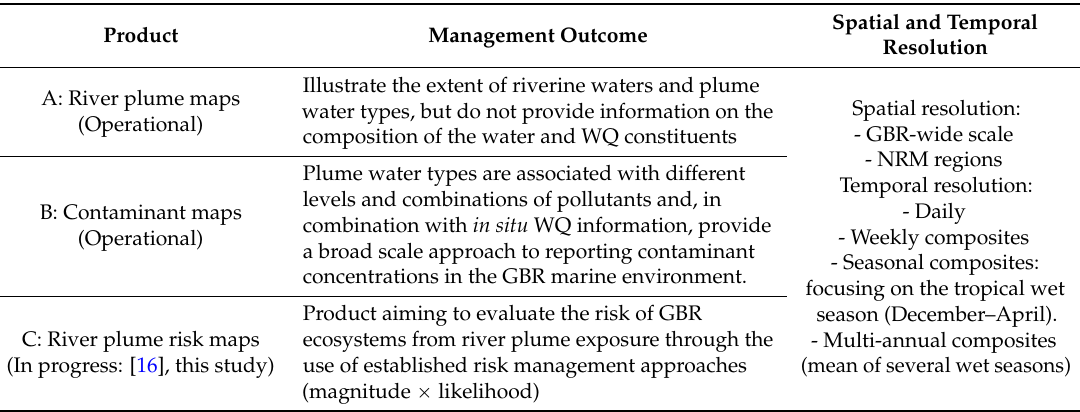
Table 1. Key remote sensing monitoring products (operational and in progress) developed through MMP (Marine Monitoring Program) funding and used to develop the present Satellite Risk